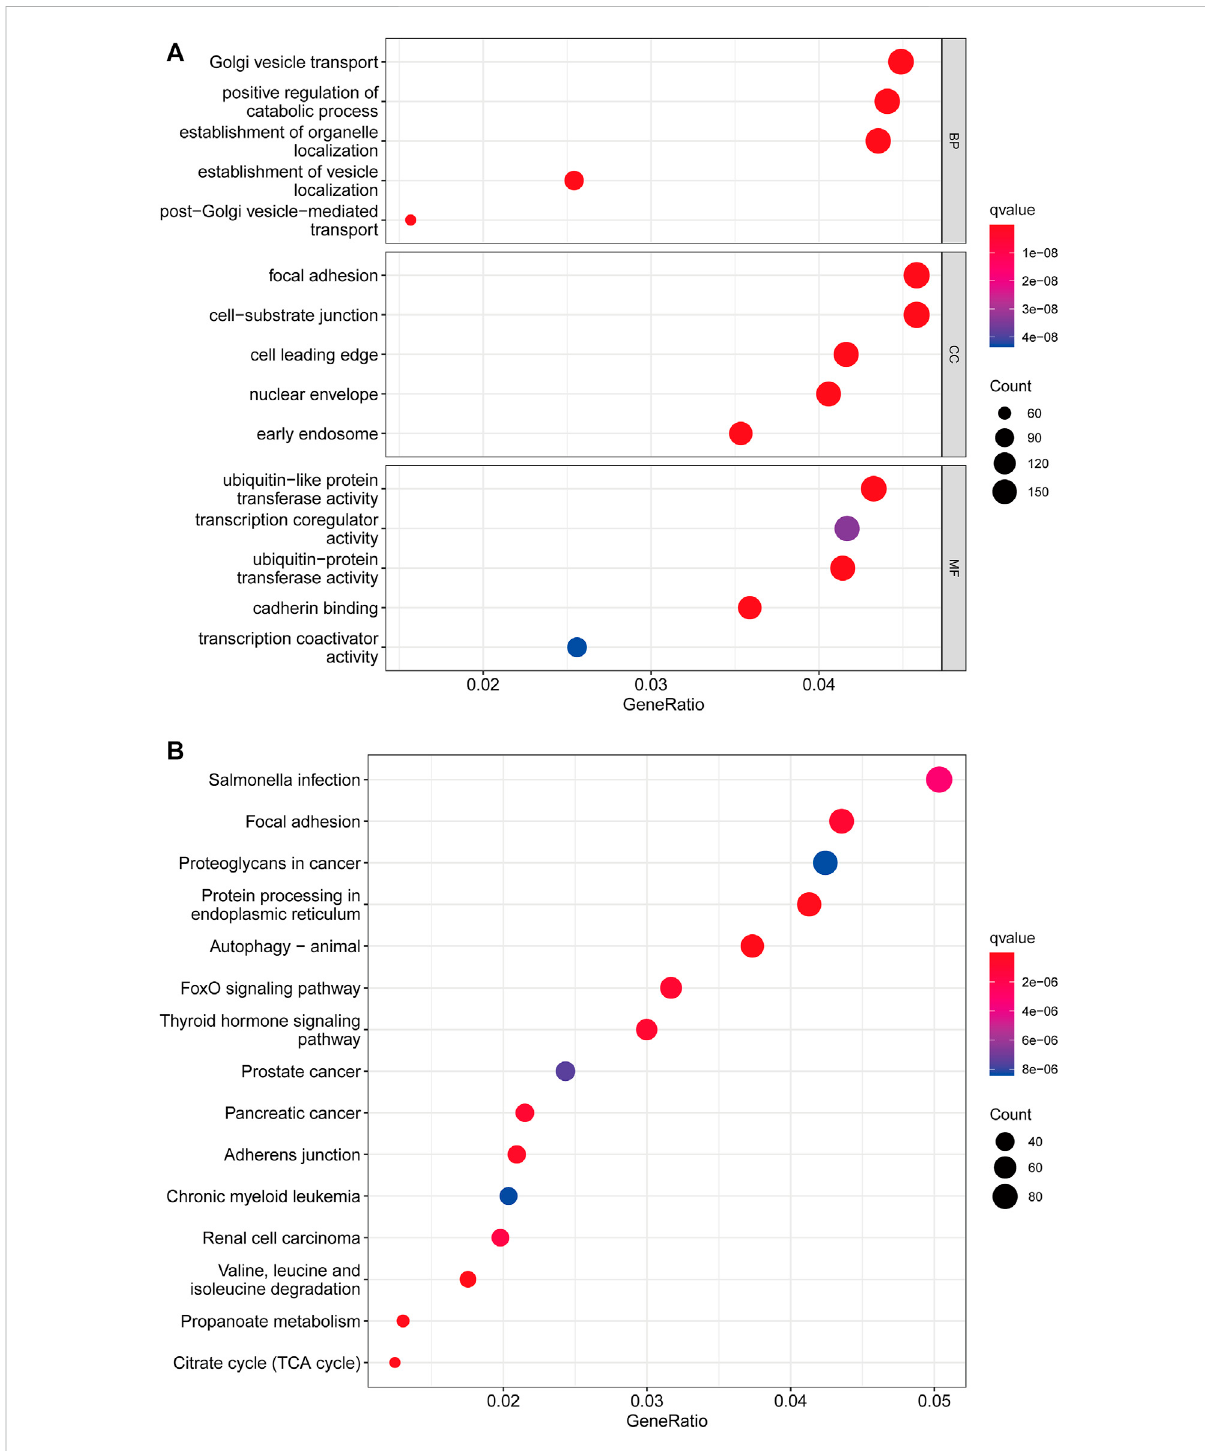
FIGURE 4 Functional enrichment analysis. (A) Bubble plot for Gene Ontology (GO) function enrichment analysis. BP: biological processes; CC: cellular components; MF: molecular function. (B) Bubble plot for Kyoto Encyclopedia of Genes and Genomes (KEGG) pathway enrichment analysis. The y-axis shows pathway terms, whereas the x-axis denotes gene ratio. The size of each circle represents the number of genes. The hue of the circles symbolizes various q